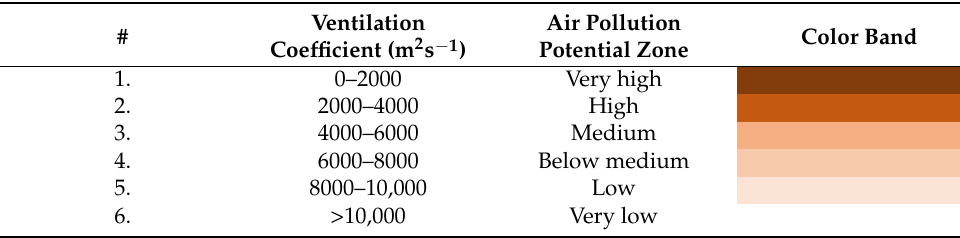
Table 2. Categories of air pollution